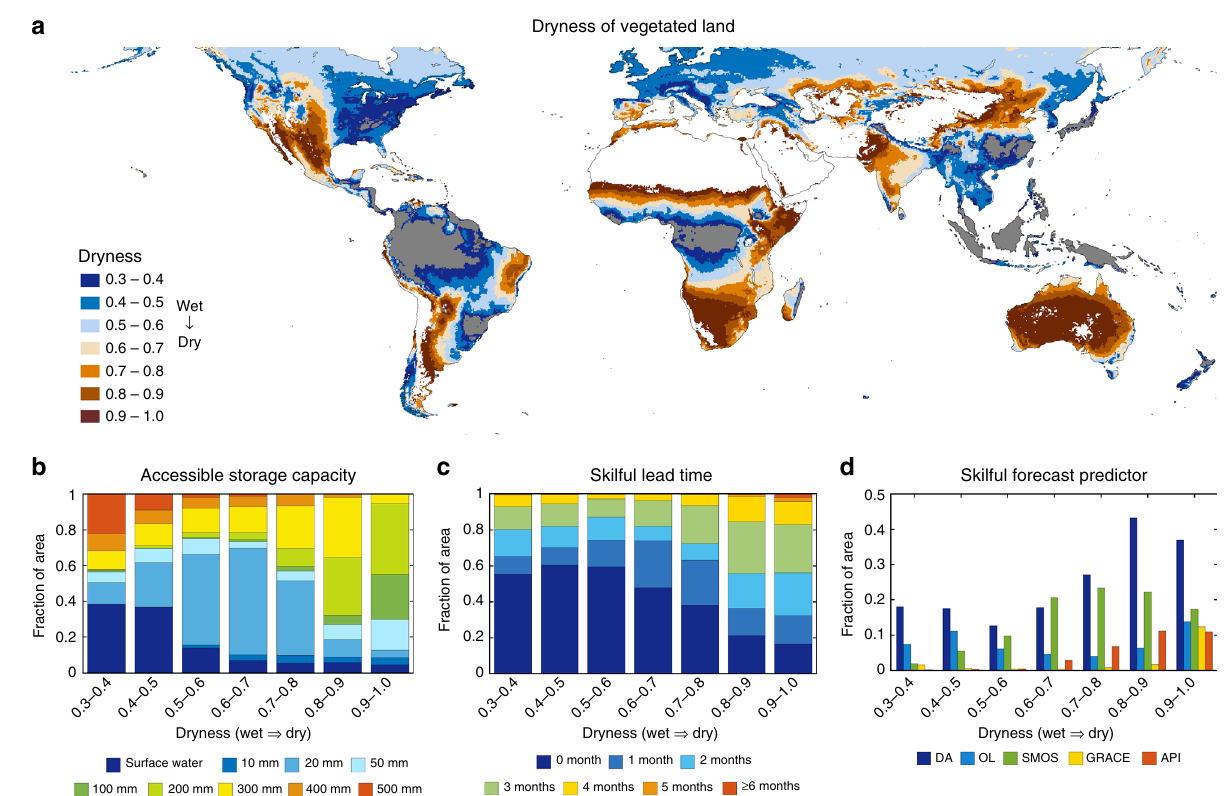
Fig. 1 Accessible storage and vegetation dynamics prediction skill. Relationship between water availability over different integration depths and vegetation greenness anomalies over humid to arid regions with dryness indices from 0.3 to 1.0. a Distribution of global drylands; areas with minimal vegetation (maximum Normalised Difference Vegetation Index (NDVI) <0.25) and generally high water availability were masked out in white and grey, respectively. b Fraction of area for accessible storage capacity in mm (surface water or below-surface) at different dryness levels. c Fraction of area for the number of months for which skilful ( ρ > 0.6) forecasts were achieved in different dryness levels. d Fraction of area for which skilful forecasts were possible 3 months in advance using data assimilation (DA), compared to those achieved using only open-loop model results without any assimilation of satellite observations (OL), using satellite-derived near-surface soil moisture (Soil Moisture and Ocean Salinity (SMOS)), using total water storage (Gravity Recovery and Climate Experiment (GRACE)) and using an index calculated from antecedent precipitation only (Antecedent Precipitation Index